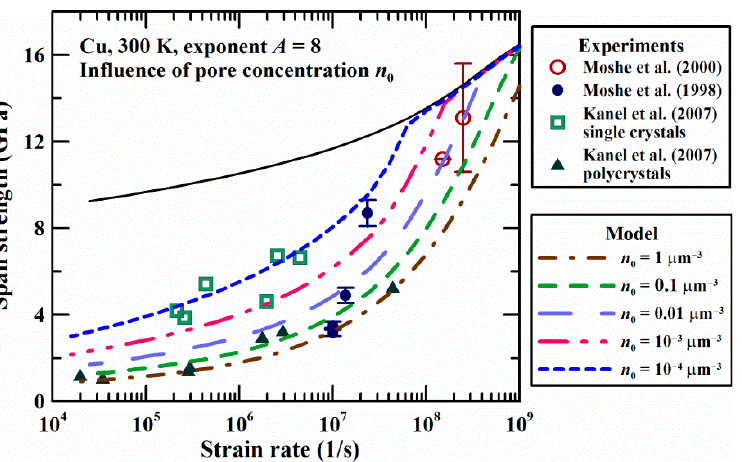
Figure 10. Influence of initial pores or non-wettable inclusions with a power-law size distribution with different total concentration on the strain rate dependence of the spall strength of copper at room temperature; model results in comparison with the experimental data of Moshe et al. (1998) [15], Moshe et al. (2000) [16], and Kanel et al. (2007) [18]; R 0 = 0.5 nm. Figure 10 shows that an increase in the total concentration of inclusions simultaneously decreases the spall strength at moderate strain rates in the mode of heterogeneous activation of voids and increases the threshold strain rates of the transition to the mode of homogeneous nucleation of